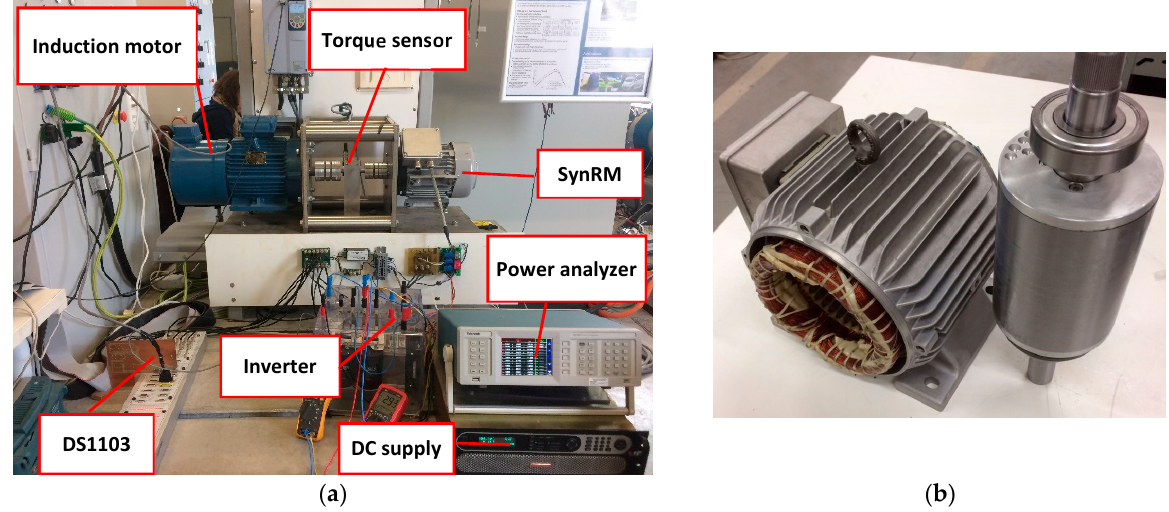
Figure 14. ( a )The complete experimental setup and ( b ) three-phase SynRM stator and rotor. Figure 14. ( a ) The complete experimental setup and ( b ) three-phase SynRM stator and rotor.